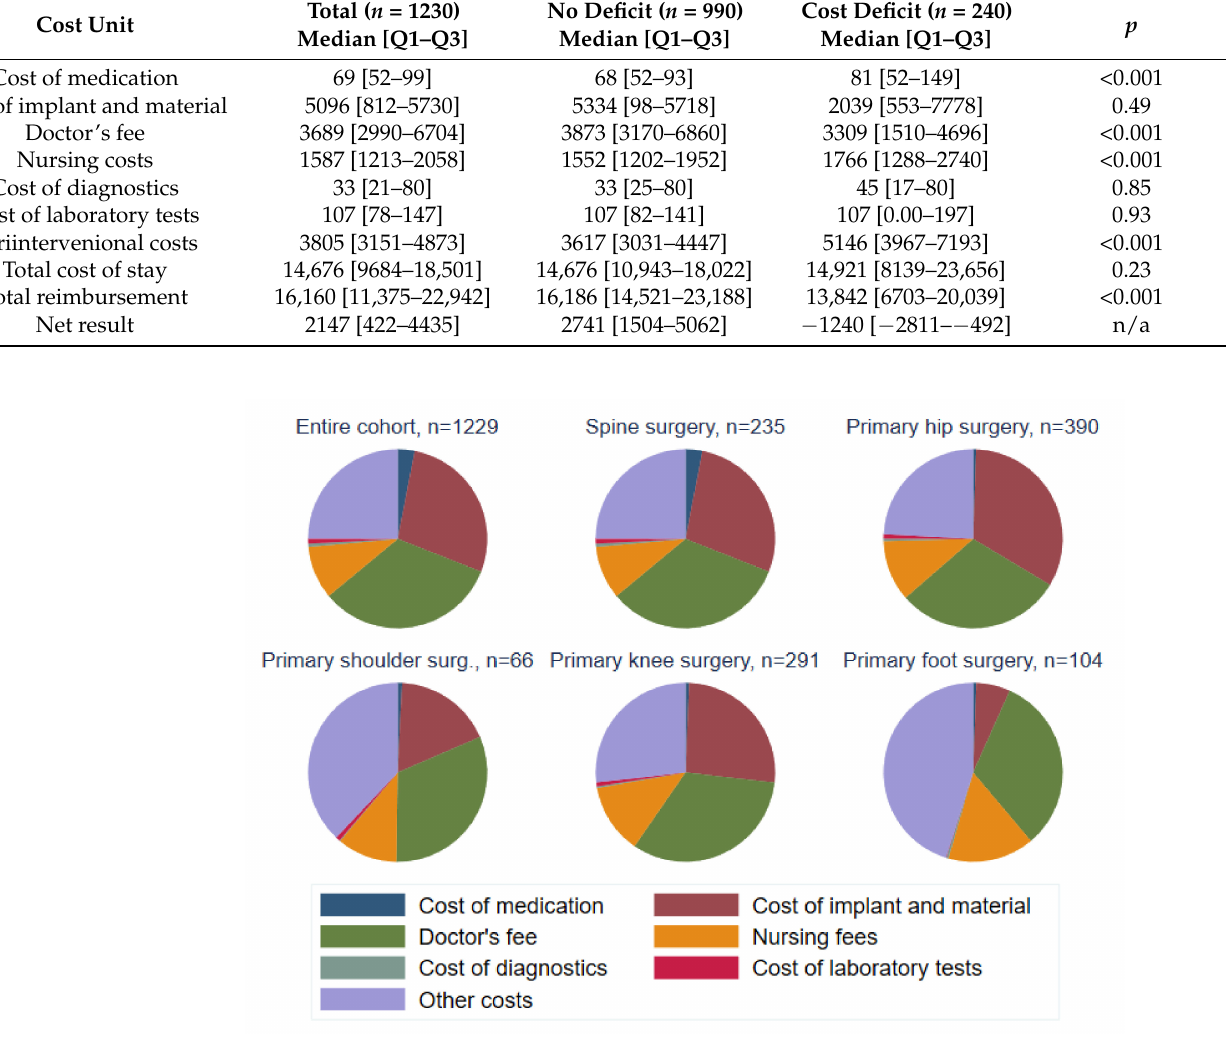
Figure 11. Relative cost distribution by cost units for main types of